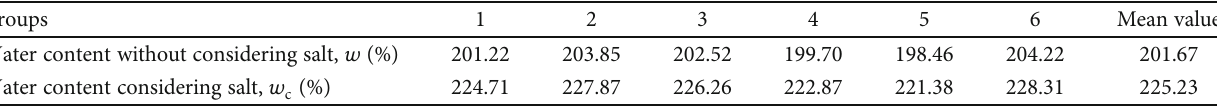
Table 2: Water content before and after correction.